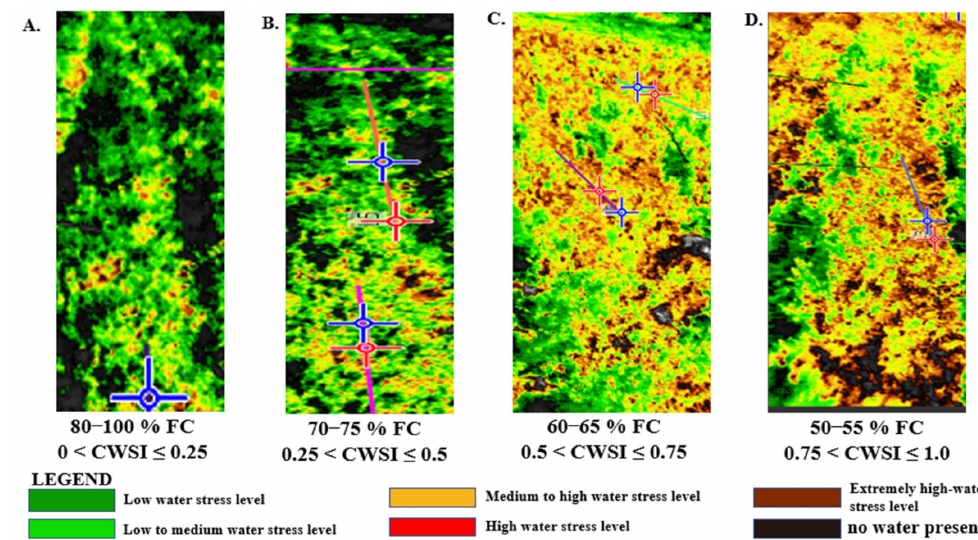
Figure 10. Isothermal imagery of the mandarin orchard depicting various water stress levels and their corresponding range of CWSI values recorded by the WWARIC. (Subset ( A ) is the isothermal image of mandarin under low water stress level ( B ). isothermal image of mandarin subjected to mild water stress ( C ). isothermal image of mandarin under moderate water stress ( D ). isothermal image of mandarin under high water stress.